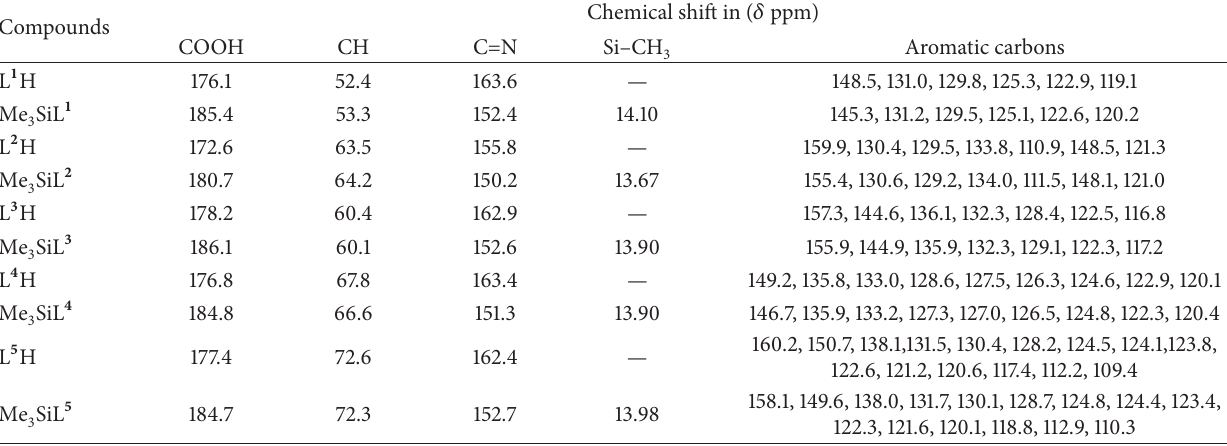
Chemical shift in ( 𝛿